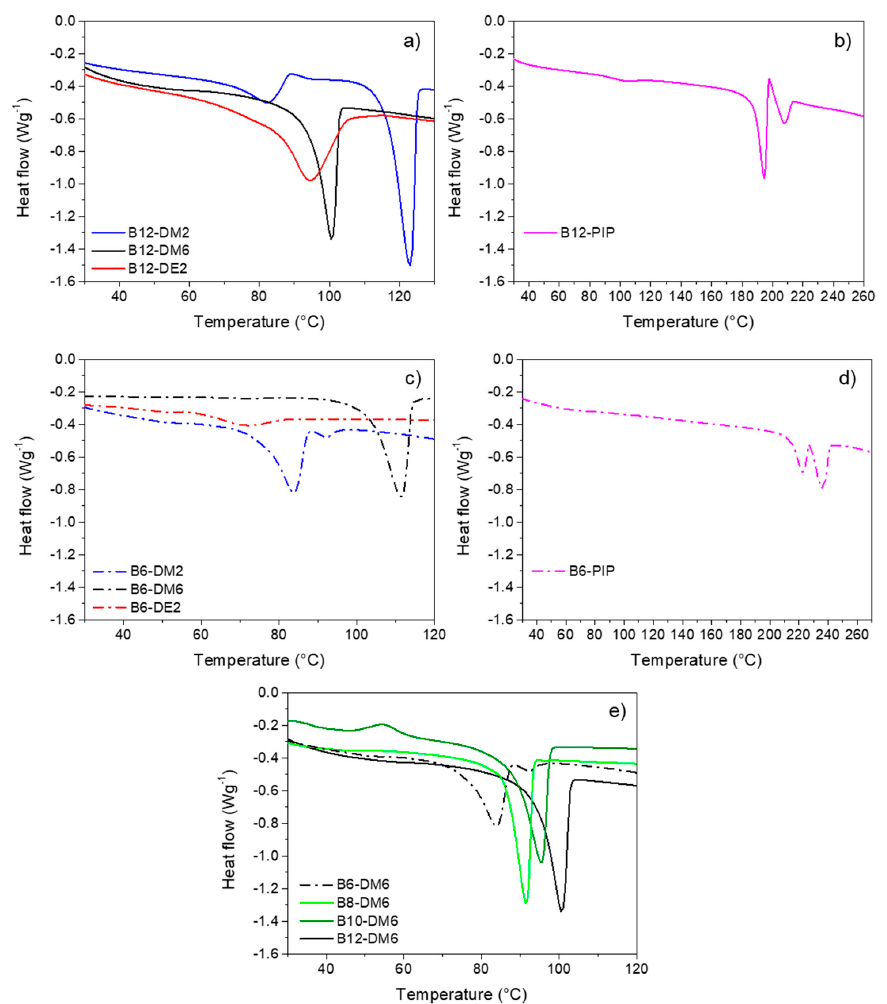
Figure 4. Differential scanning calorimetric (DSC) thermograms pertaining to the 2nd heating cycle at 10 °C min − 1 of: ( a ) B12-DM2, B12-DM6 and B12-DE2; ( b ) B12-PIP; ( c ) B6-DM2, B6-DM6 and B6-DE2; ( d ) B6-PIP; ( e ) B6-DM6, B8-DM6, B10-DM6 and B12-DM6.